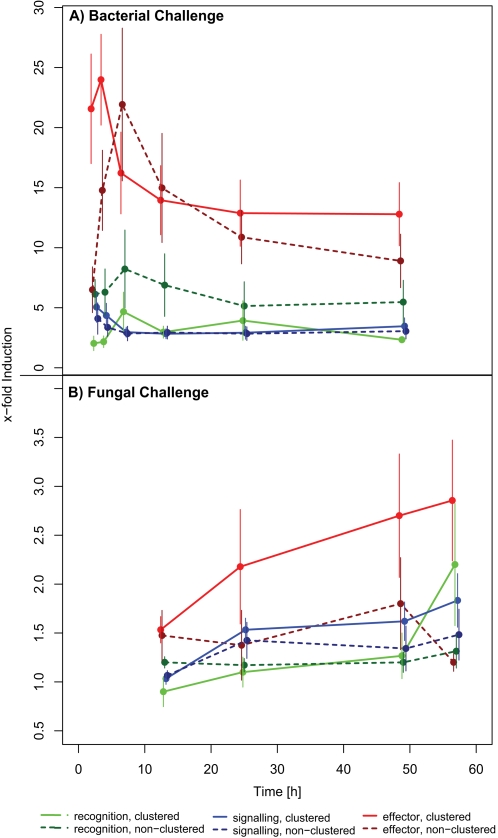
Induction of D. melanogaster immune genes after A) bacterial and B) fungal challenge.Expression data was obtained for 50 highly induced or surpressed genes from [25] and genes were grouped according to their function during the immune response and whether they were contained in a cluster (solid lines) or not (dashed lines).